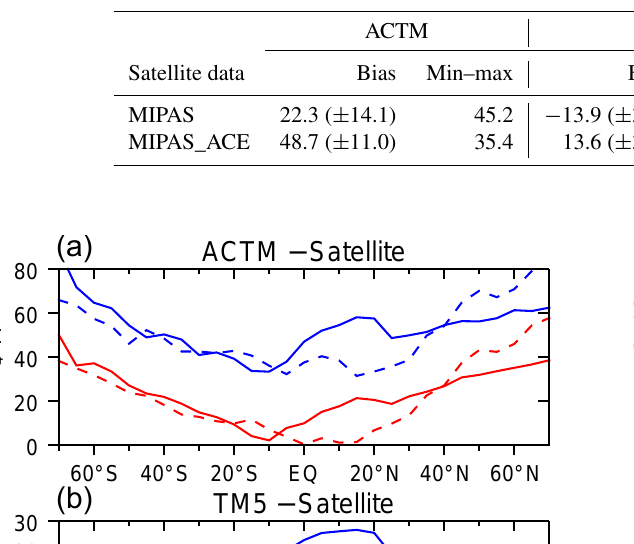
Table 5. Average XCH 4 differences between model simulations and model CH 4 fields with satellite-based stratospheric CH 4 fields. Annual mean differences as XCH 4 bias (with 1 σ SD) and minimum–maximum range of zonal XCH 4 differences are inppb.